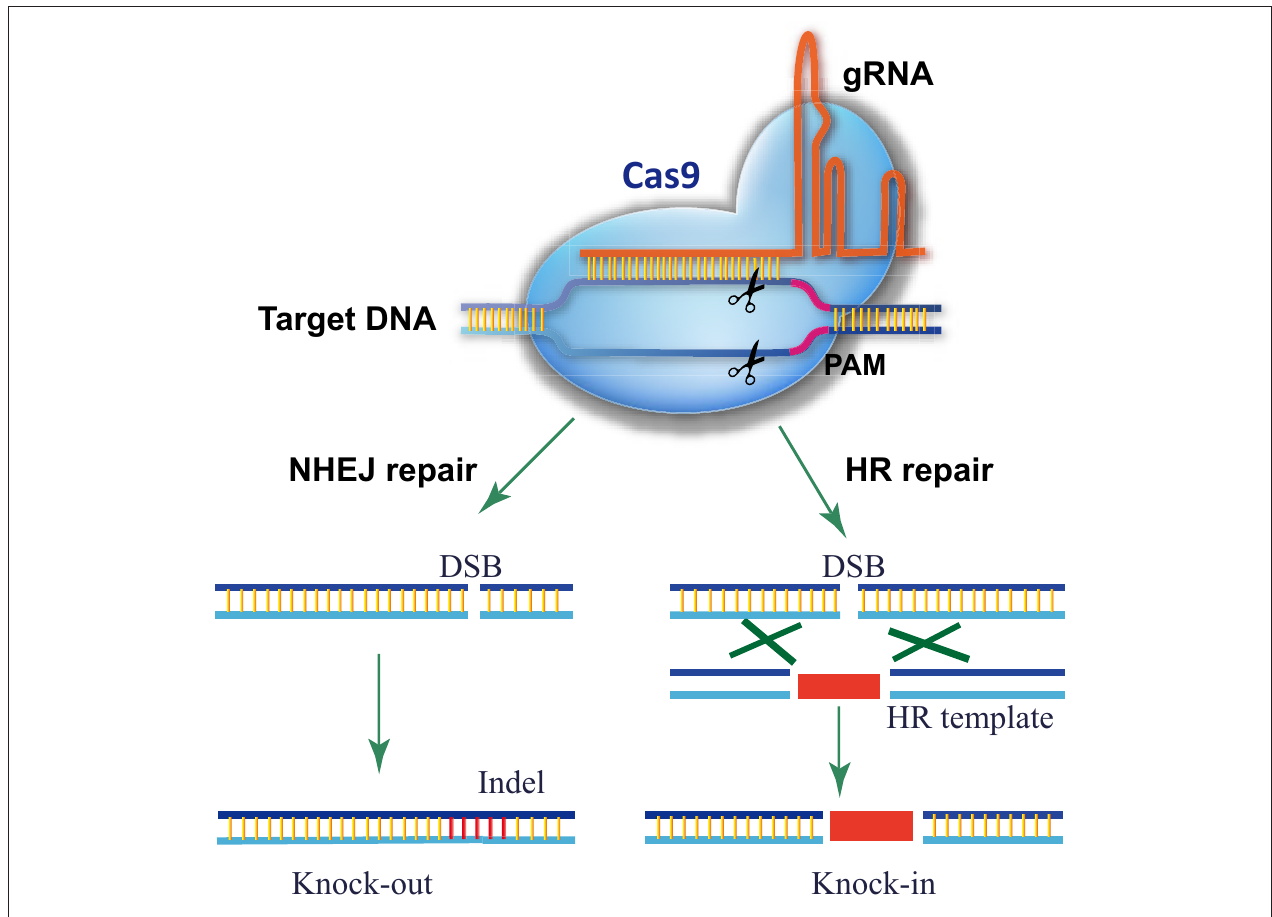
FIGURE 1 | Schematic of Cas9/gRNA genome editing. Cas9 is directed to its DNA target by base pairing between the gRNA and DNA. A PAM motif downstream of the gRNA-binding region is required for Cas9 recognition and cleavage. Cas9/gRNA cuts both strands of the target DNA, triggering endogenous DSB repair. For a knockout experiment, the DSB is repaired via the error-prone NHEJ pathway, which introduces an inDel at the DSB site that knocks out gene function. In a knock-in experiment, the DSB is repaired by HDR using the donor template present, resulting in the donor DNA sequence integrating into the DSB site.